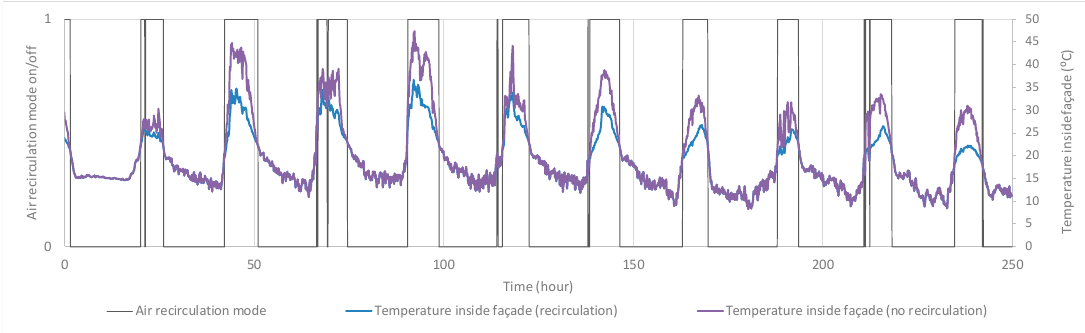
Figure 8. Periods for positive heat gains through air recirculation inside the façade.